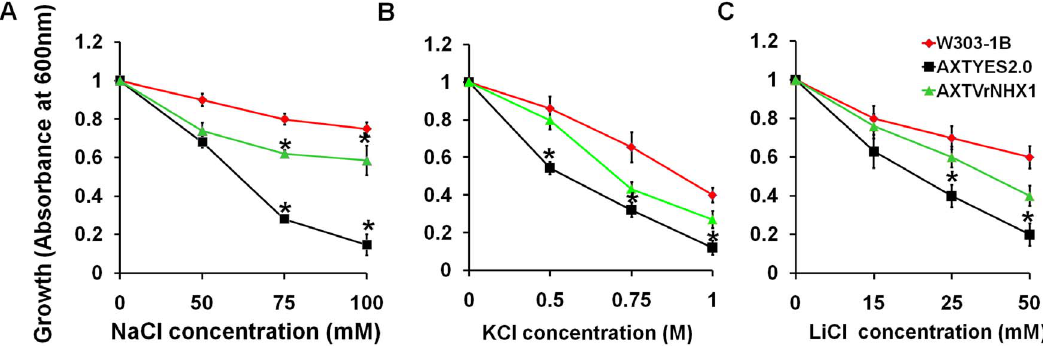
Figure 3. Cation sensitivity assay of transformed yeast strains (W303-1B, AXTYES2.0, AXTVrNHX1) under various concentrations of NaCl, KCl, and LiCl. Saturated seed cultures for each strain was diluted to an OD 600 of 0.006 and inoculated to liquid APGal medium (pH 5.5) supplemented with or without various concentrations of (A) NaCl (0, 50, 75, 100 mM), B) KCl (0, 0.5, 0.75, 1.0 M), and (C) LiCl (0, 15, 20, 25 mM). Growth was observed at 30 u C after 3 days and absorbance recorded at 600 nm. Data are means of 3 independent events (n=3) and standard errors are plotted in the graph. Statistically significant values at P # 0.05 are indicated as ‘‘*’’, using Bonferroni analysis.